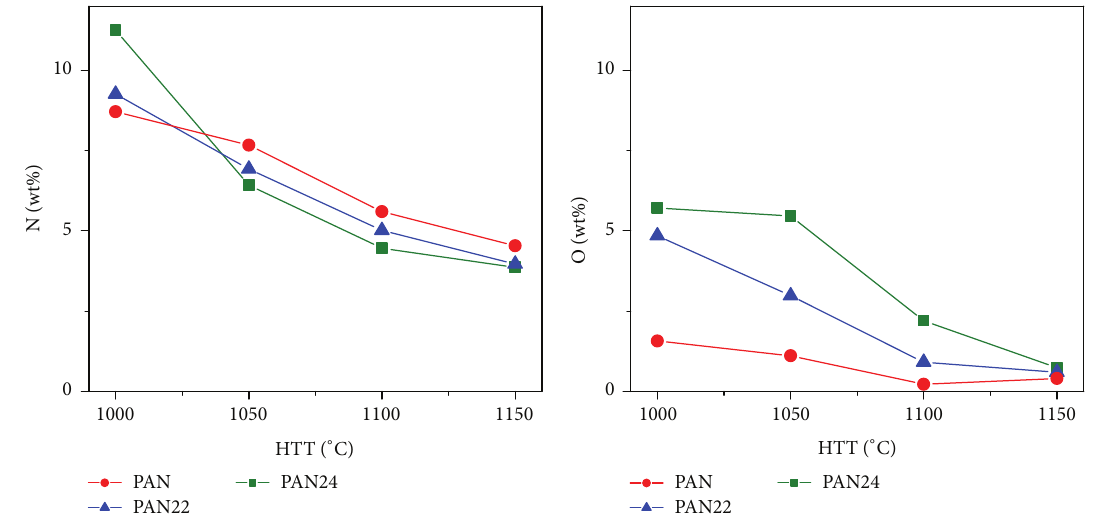
Figure 1: Effect of HTT on nitrogen and oxygen contents in PAN-based carbons.